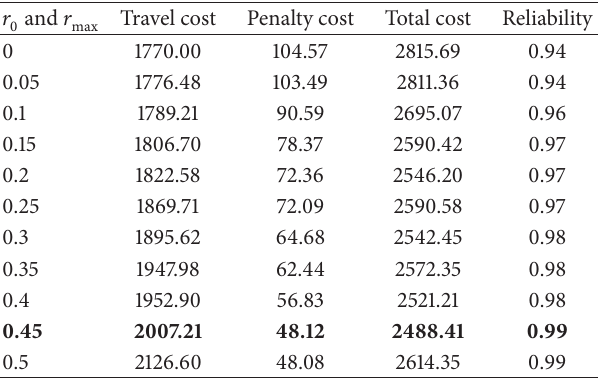
Table 2: Results of alternative solutions to the RC101 instance with medium